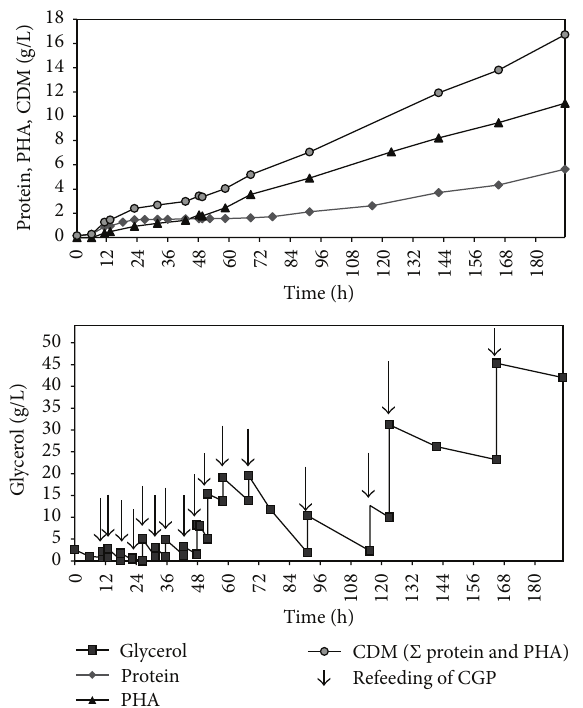
Figure 3: Concentrations of the substrate and the products during fermentation. Arrows indicate the re-feeding of substrate.